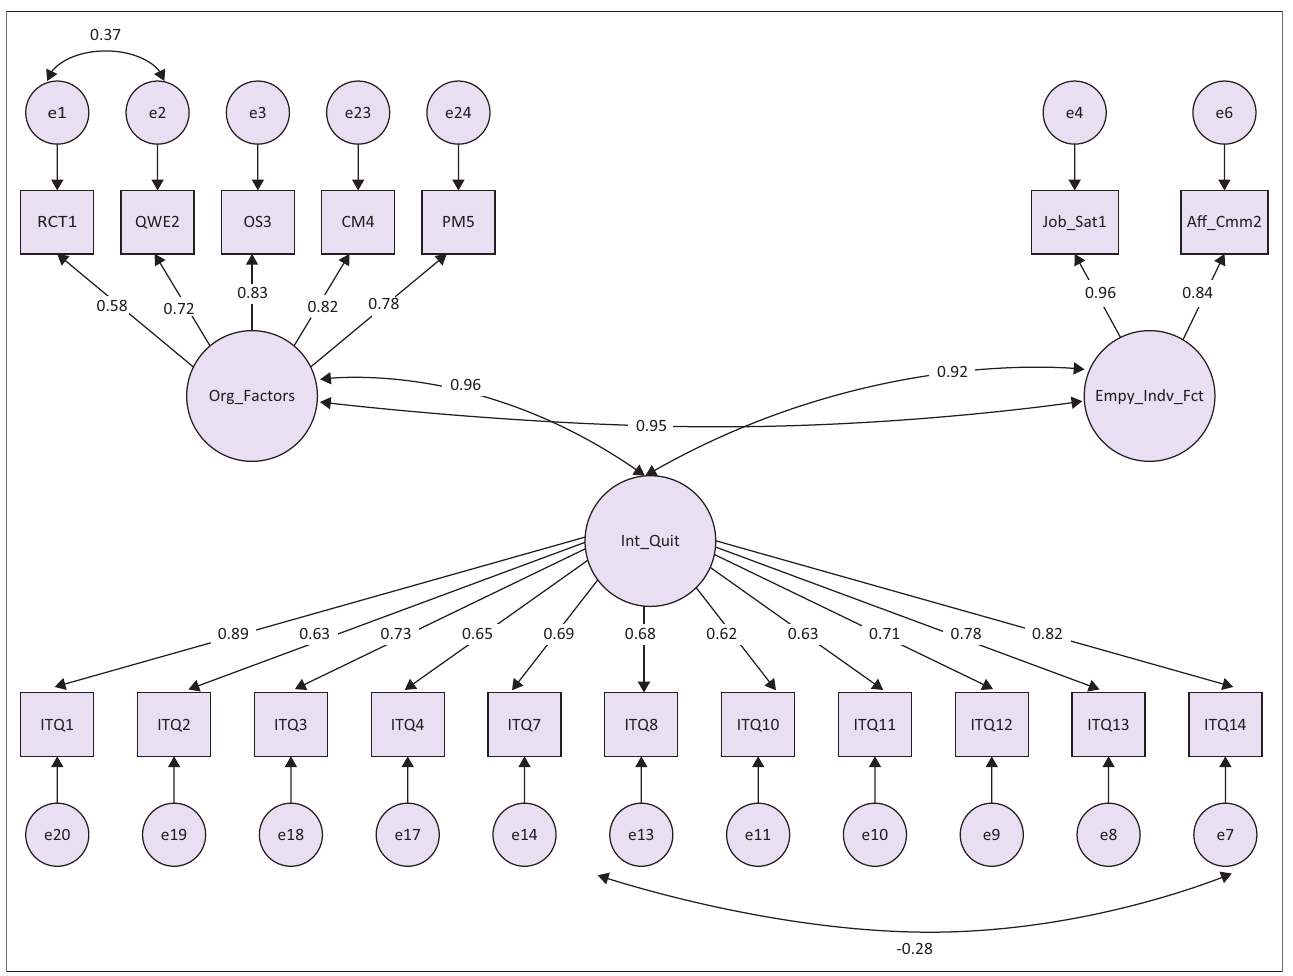
FIGURE 3: The final measurement